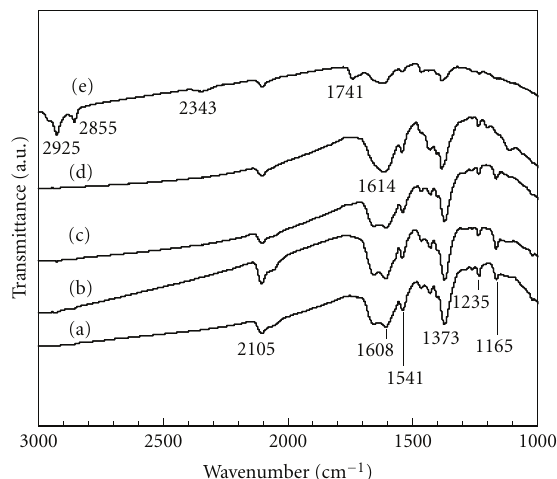
Figure 6: Current-Voltage characteristics for DSCs prepared using TiO 2 nanocrystals